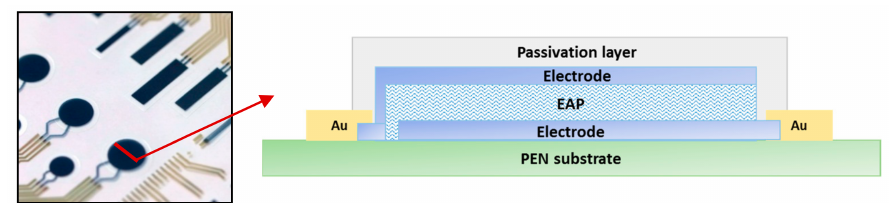
Figure 1. Schematic cross section of the piezoelectric EAP stack that actuates a movable mechanical layer (beam or circular membrane) using the unimorph effect. The location of the cross section is illustrated on the photograph of the polymer actuators.